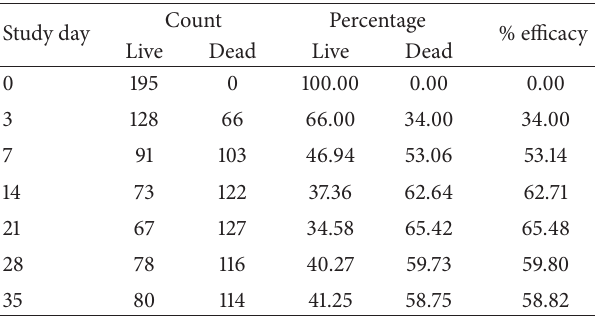
Table 1: Efficacy and speed of kill of Fiprofort Plus spot-on against ticks during 35 days of the